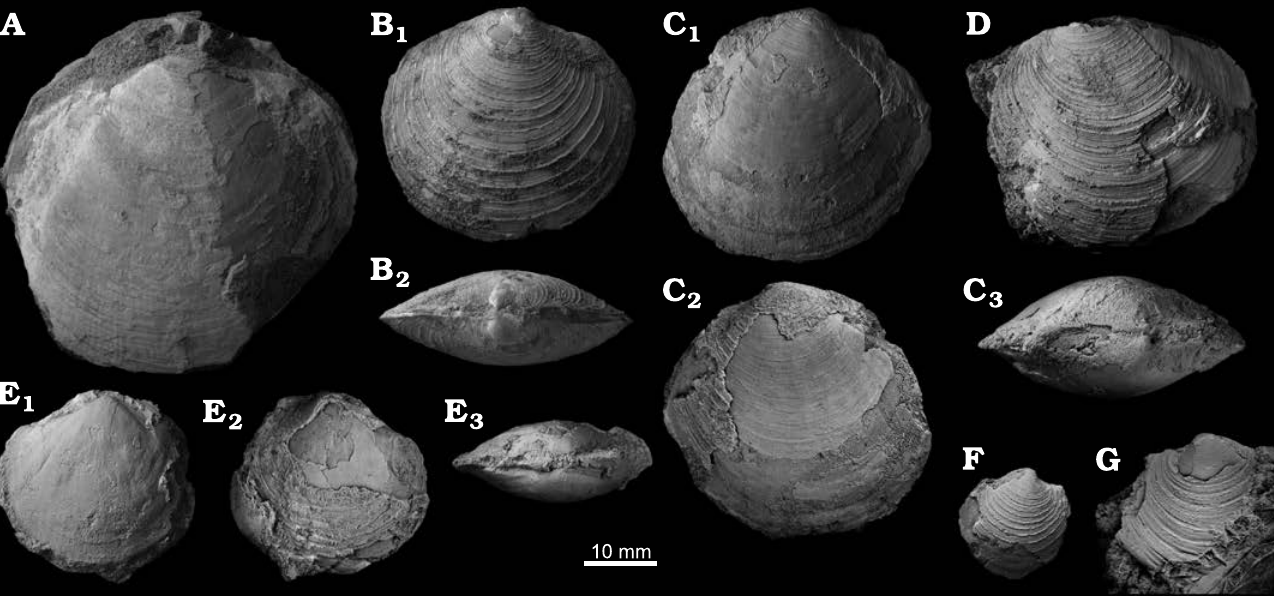
Fig. 10. The lucinid bivalve Lucinoma acutilineata (Conrad, 1947) from Upper Miocene seep deposits of the Amlang Formation in Pangasinan province, Luzon, Philippines. A . NIGSPAL-023, large articulated specimen, view on RV. B . NIGAPAL-024, medium-sized, articulated specimen, view on RV showing outline and widely spaced commarginal ribs (B 1 ), and dorsal view showing inflation, lunule and escutcheon. C . NRM Mo 192429, articulated specimen with most shell material detached, showing muscle scars and pallial line, view on RV (C 1 ), LV (C 2 ) and on dorsal side (C 3 ). D . NRM Mo 192584, specimen with broken apical portion, view on LV. E . NRM Mo 192430, small specimen, RV mostly an internal mold showing muscle scars and pallial line (E 1 ), LV with preserved shell (E 2 ), and view on dorsal side showing ligament (E 3 ). F . NRM Mo 192428, small RV showing external sculpture. G . NRM Mo 192634, small LV showing external